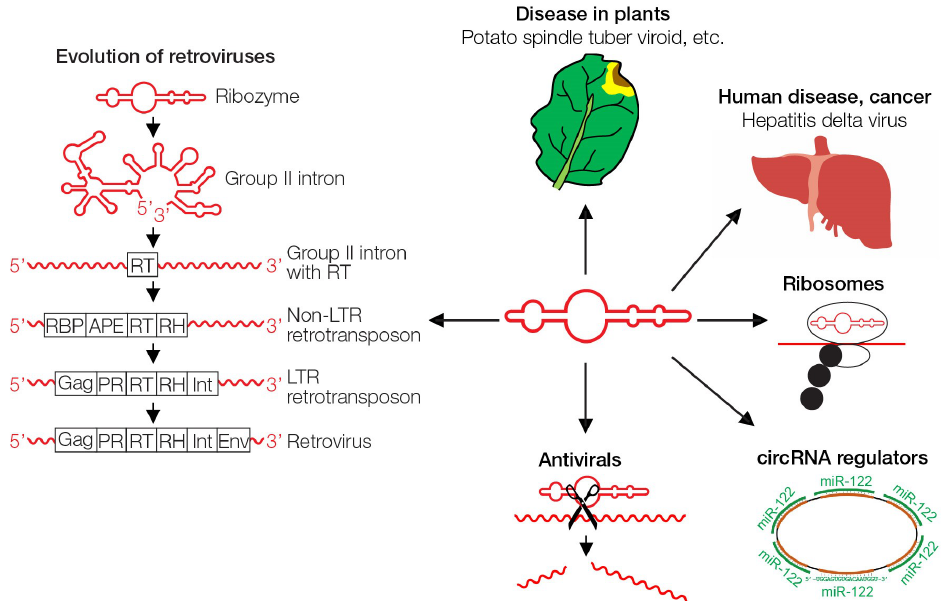
Figure 3. Multifunctionality of RNA. Ribozymes / viroids and related RNAs can cause disease in plants [50–54], contribute as HDV to liver cancer in humans [56], can perform peptide synthesis in ribosomes [28], act as regulatory circRNA [49], have been used for sequence-specific cleavage in gene therapy approaches [58], and ribozymes have evolved gradually to today’s retroviruses by acquiring coding information [47]. RT, reverse transcriptase; RBP, RNA-binding protein; APE, apurinic endonuclease; RH, ribonuclease H; Gag, group-specific antigen; PR, protease; Int, integrase; Env,